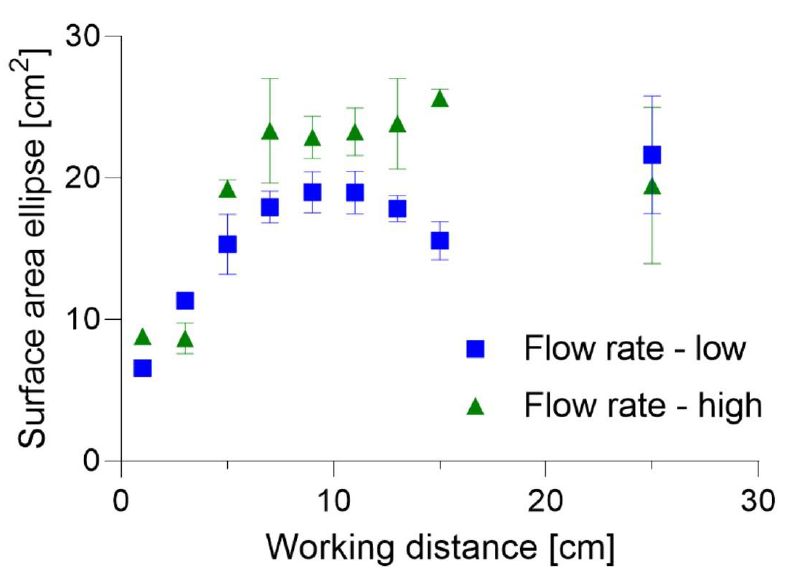
Figure 3. Mean surface area of the sprayed ellipse. Comparison of high and low spraying flow rate.